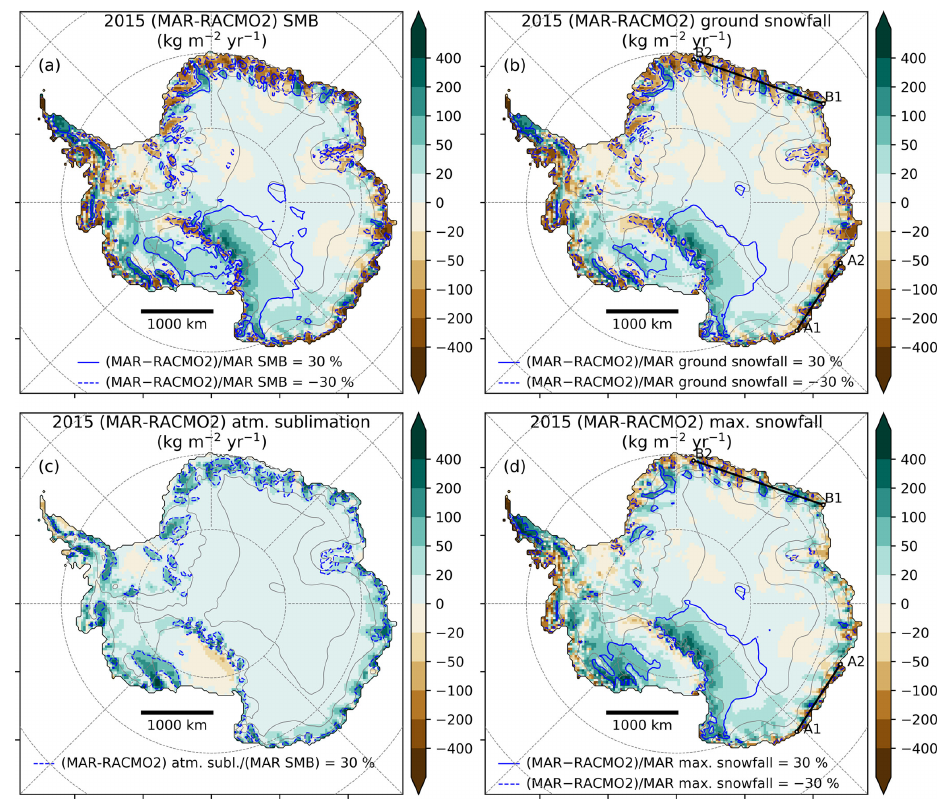
Figure 5. The four maps show mass fluxes in kgm − 2 yr − 1 for the year 2015. (a) Difference in SMB between MAR and RACMO2. Blue lines delimitate areas where the SMB difference is 30% greater than MAR SMB, with solid lines when MAR is greater than RACMO2 and dashed lines when MAR is lower than RACMO2. (b) Same as (a) but for the snowfall amounts at the ground. (c) Same as (a) but for the sublimation of precipitation in the atmospheric layers. (d) Same as (a) but for the maximum snowfall amount (equal to ground snowfall plus atmospheric sublimation). Locations of transects A1–A2 and B1–B2 extracted in Fig. 6 are shown in panels (b) and (d)